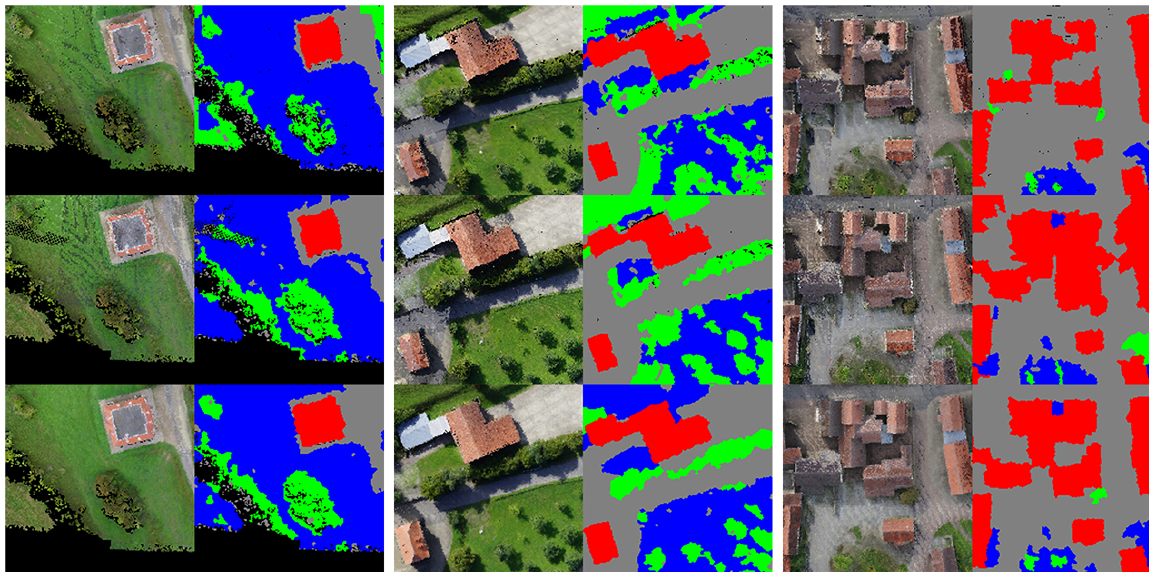
Figure 10. The top row shows classification results on the point cloud from complex fusion (Kuhn et al., 2014) (Figure 9 [left]). Results for the fast proposed probabilistic fusion but without considering probabilities (Figure 9 [centre]) are shown in the middle row and for probabilities derived by Equations 1 to 3 (Figure 9 [right]) results are given in the bottom row (red – buildings, gray – ground, blue – grass, and green – trees).